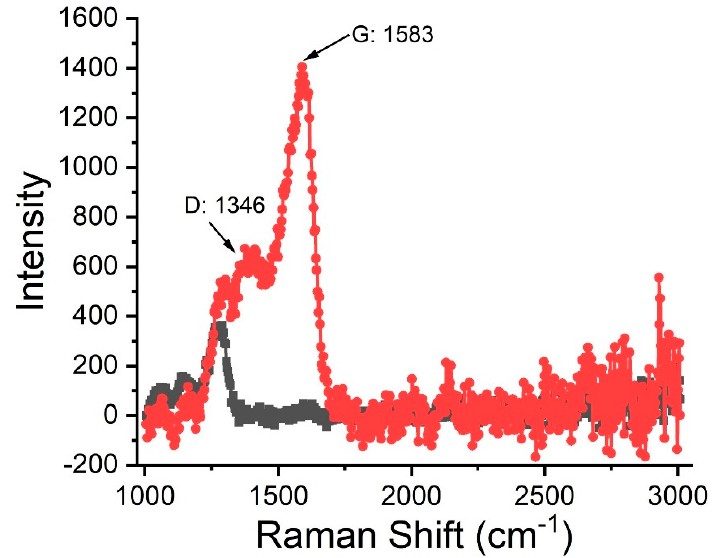
Figure A9. Raman spectrum of the carbon film grown on the Cu foil substrate, where the red line shows that the measurement has the D and G peaks, while the black line shows that the measurement does not have the D and G peaks.